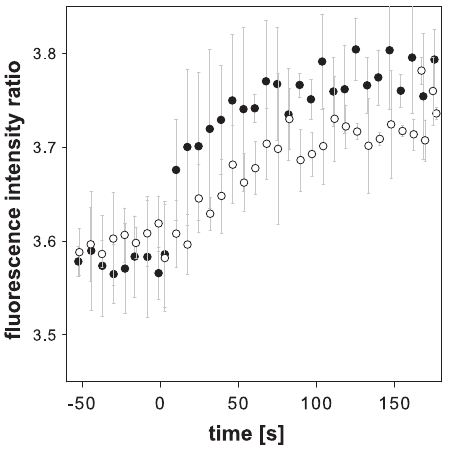
Figure 4. Citrate concentration changes in E.coli in response to carbon substrates after 24 hours of starvation. Addition of substrates is indicated as time point t=0. Manual addition interrupted the measurement for approximately 10 s. Black dots: glucose, white dots: acetate. Time points are averaged over three independent